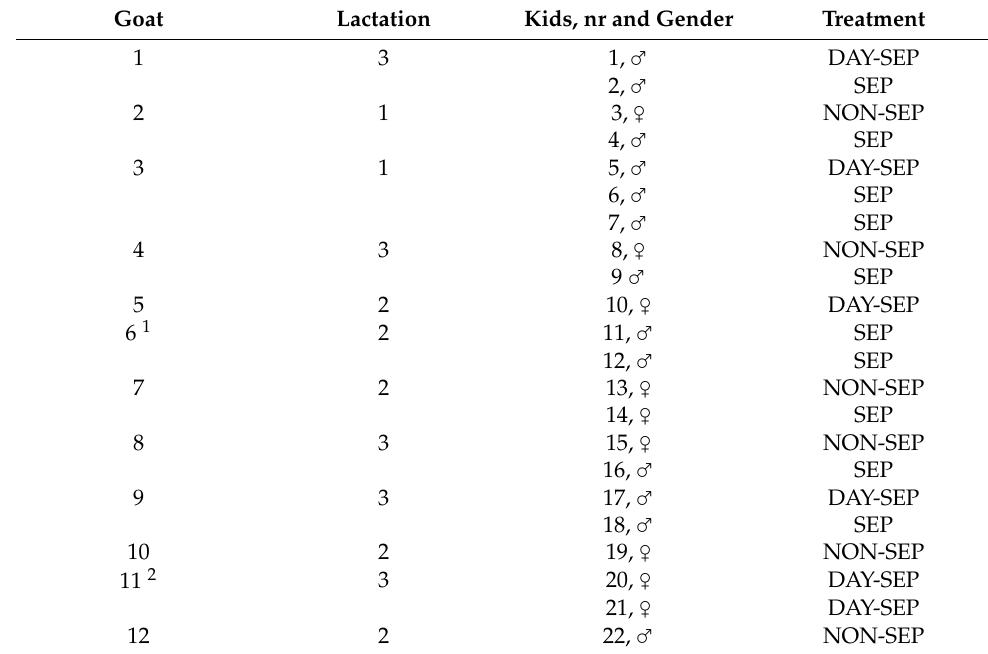
Table 1. Participating goats and kids in the different treatments. Goat Lactation Kids, nr and Gender